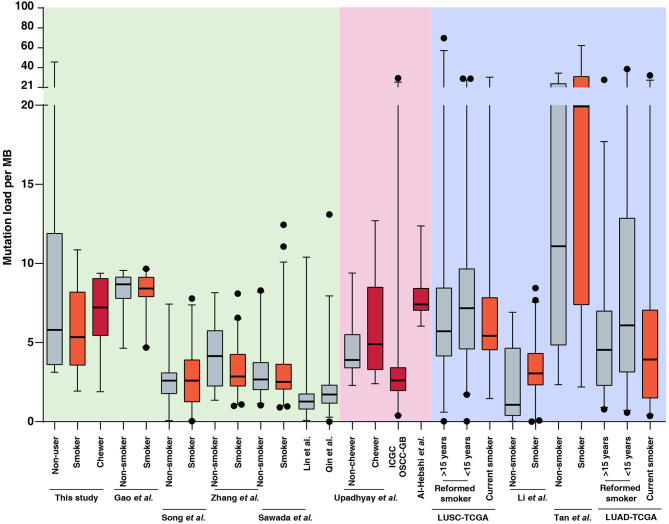
Mutation load observed in tumors from tobacco users and non-users in this study and publicly available datasets of esophageal squamous cell carcinoma (ESCC), oral squamous cell carcinoma (OSCC), lung squamous cell carcinoma (LUSC), and lung adenocarcinoma (LUAD). Black dots represents outliers identified using 97.5 percentile interval. Mutation burden for each sample in ESCC, OSCC, LUSC, and LUAD datasets is provided in Supplementary Table 5 and plotted as per tobacco consumption history.